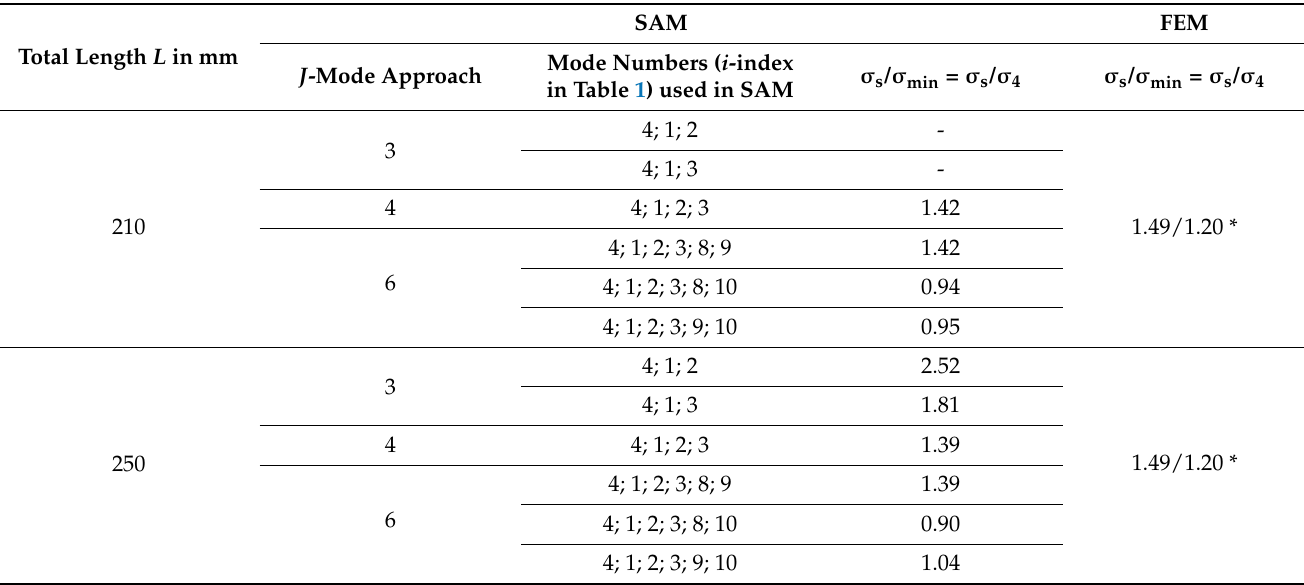
Table 2. Absolute ultimate load-carrying capacity of